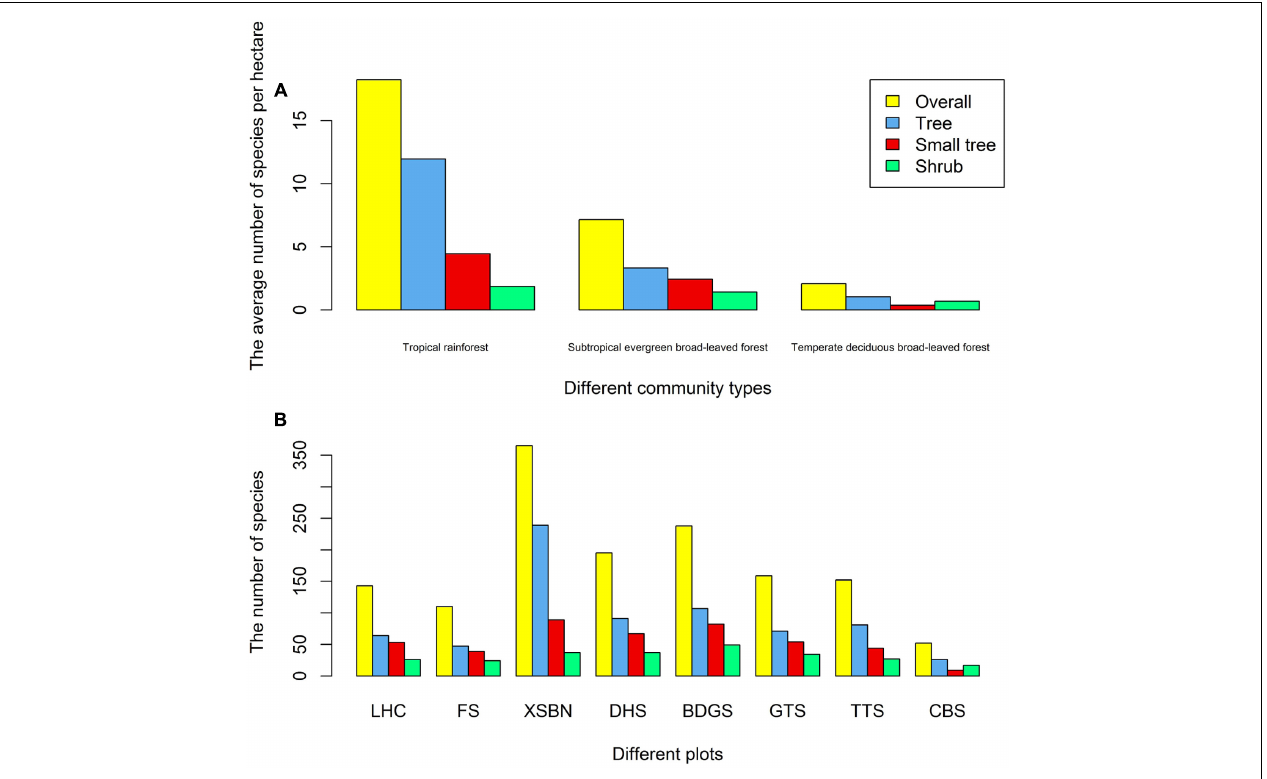
FIGURE 2 | Number of species in different community types (A) or different plots (B). Abbreviations: LHC, Lianhuachi plot; FS, Fushan plot; XSBN, Xishuangbanna plot; DHS, Dinghushan plot; BDGS, Badagongshan plot; GTS, Gutianshan plot; TTS, Tiantongshan plot; CBS, Changbaishan plot.